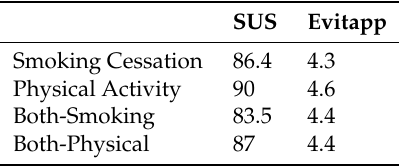
Table 3. SUS and Evitapp questionnaire scores for participant